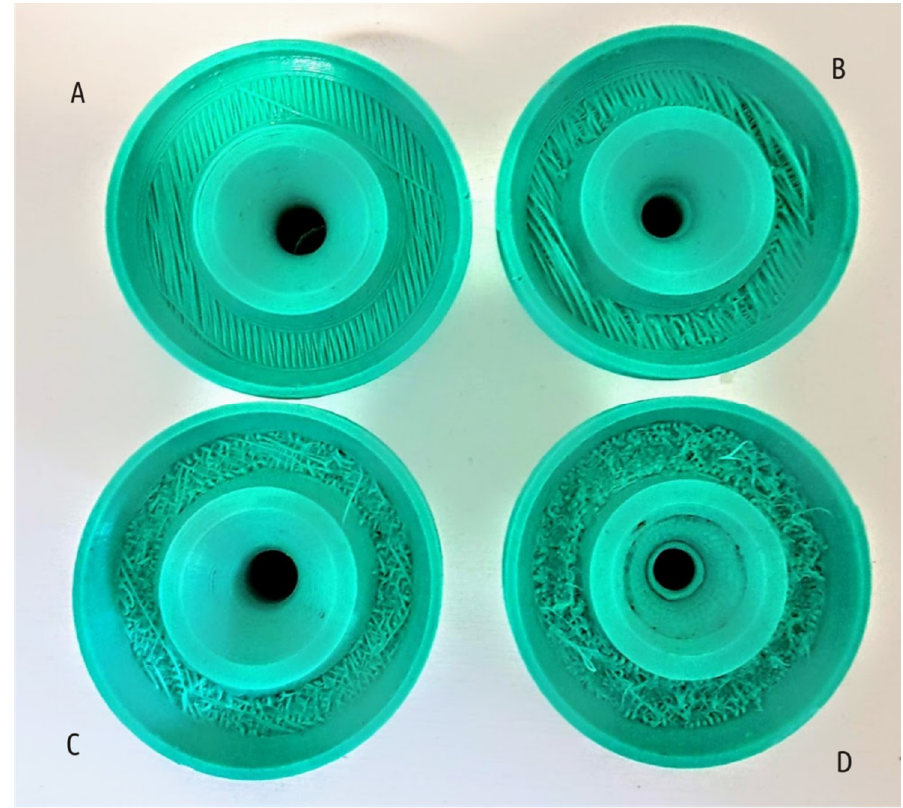
Figure 7. Shape 5 samples, bottom view: overhanging part of the boss when printing in the modes A, B, C, and D, as labeled.